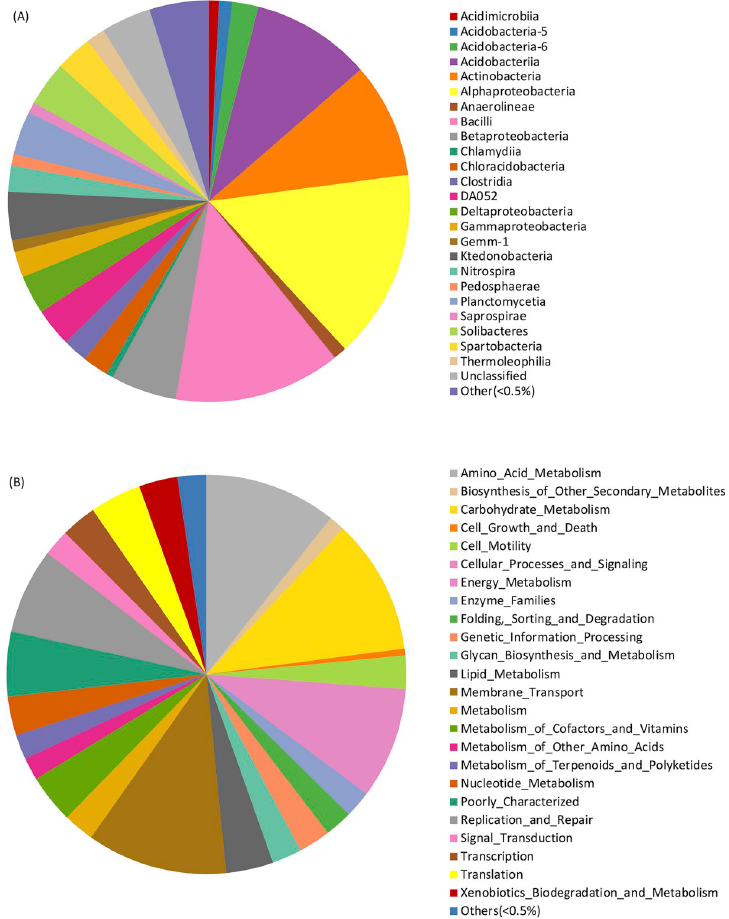
Fig 5. Bacterial community composition and predicted function. (A) Class-level relative abundance of bacteria in the soil sample. (B) KOs-prediction of function analysis based on 16S rRNA using PICRUSt. https://doi.org/10.1371/journal.pone.0236518.g005 PLOS ONE | https://doi.org/10.1371/journal.pone.0236518 July 23,